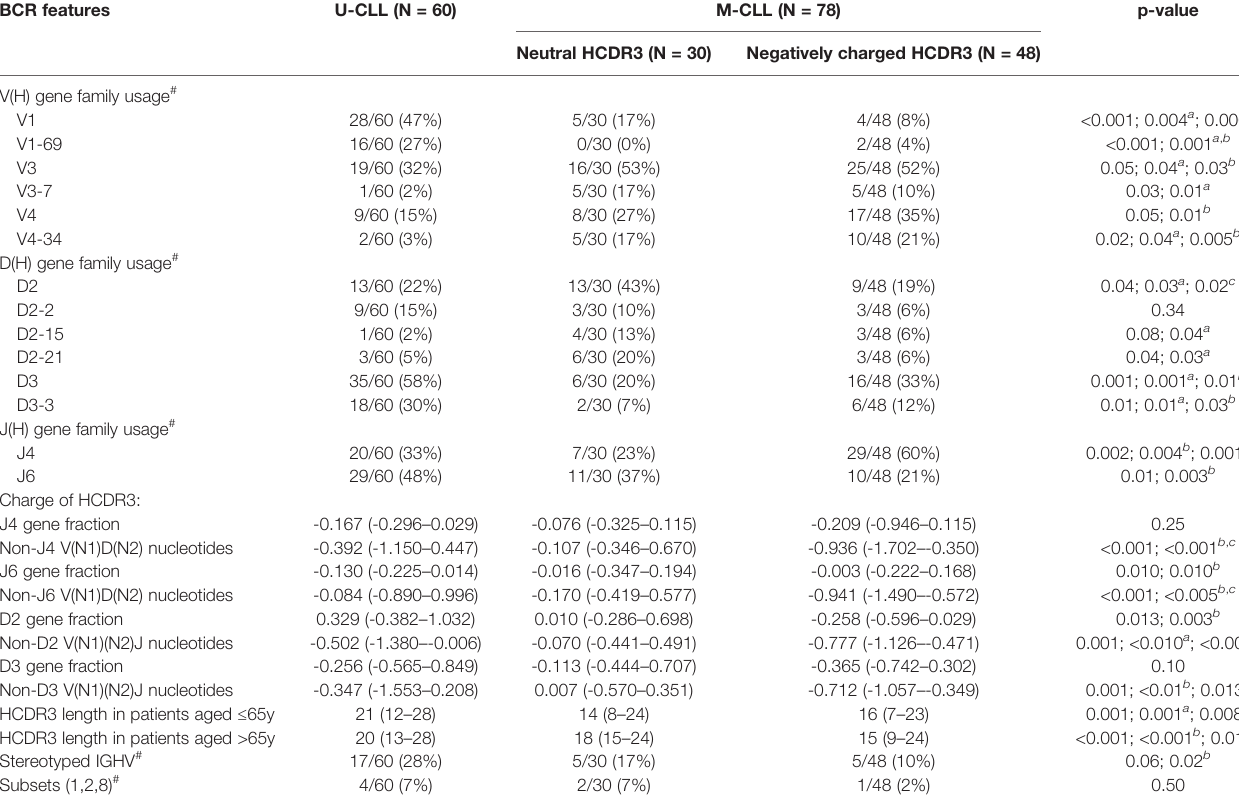
TABLE 4 | IGHV(D)J gene usage in CLL patients classi fi ed according to their IGHV mutational status and the HCDR3 hydropathy index. BCR